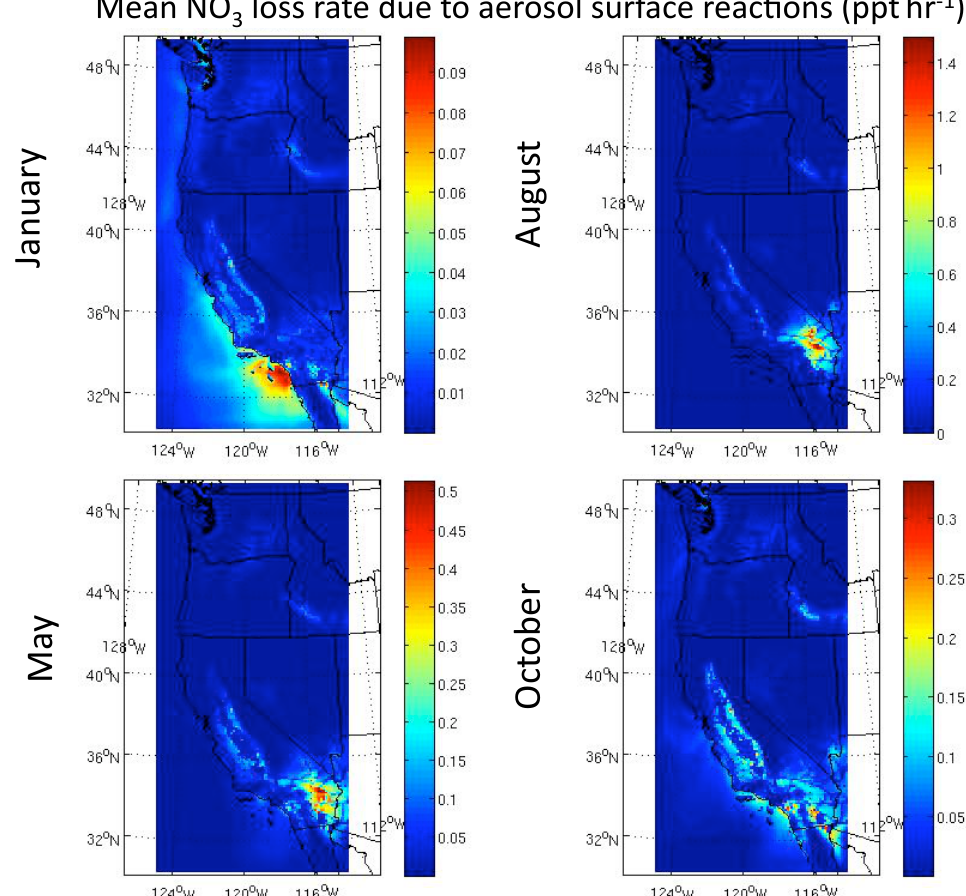
Fig. 6. Seasonal pattern of NO 3 loss rate as a result of heterogeneous reactions on OA surfaces.